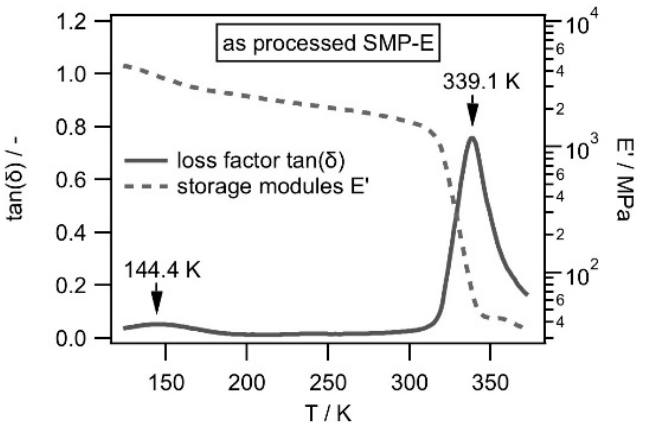
Figure 4. Dynamic mechanical thermal analysis (DMTA) results obtained for the as processed SMP-E.